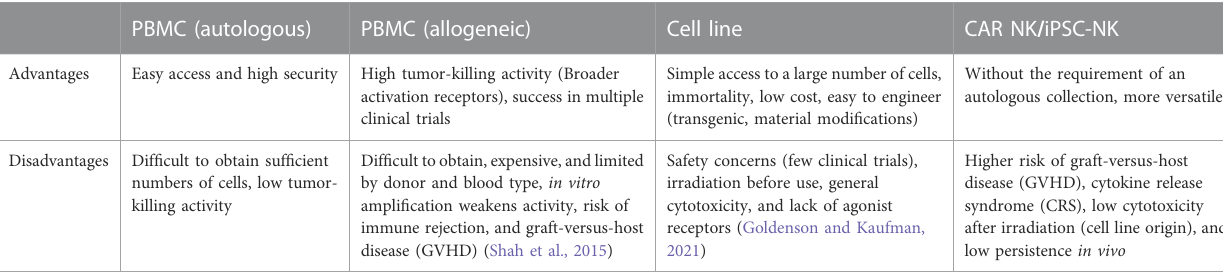
TABLE 1 Advantages and disadvantages of the mainstream NK cell sources.